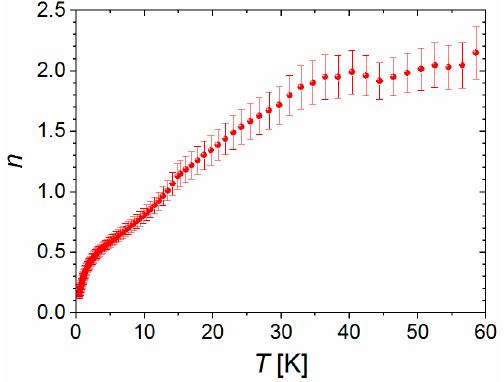
Figure 6. Temperature dependence of exponent n determined for 1 .